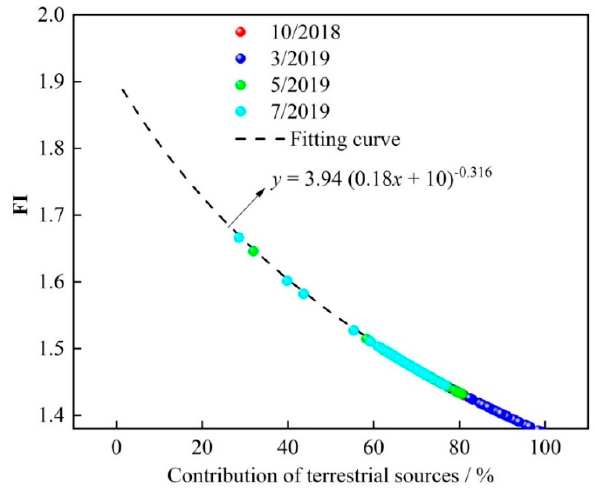
Figure 7. Relationship between the fluorescence index (FI) and contribution of terrestrial sources of the DOM in the overlying water of Lake Hulun.